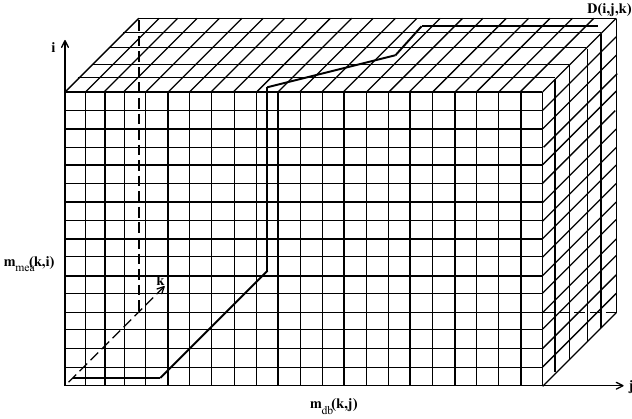
Figure 2. 3DDTW distance calculation